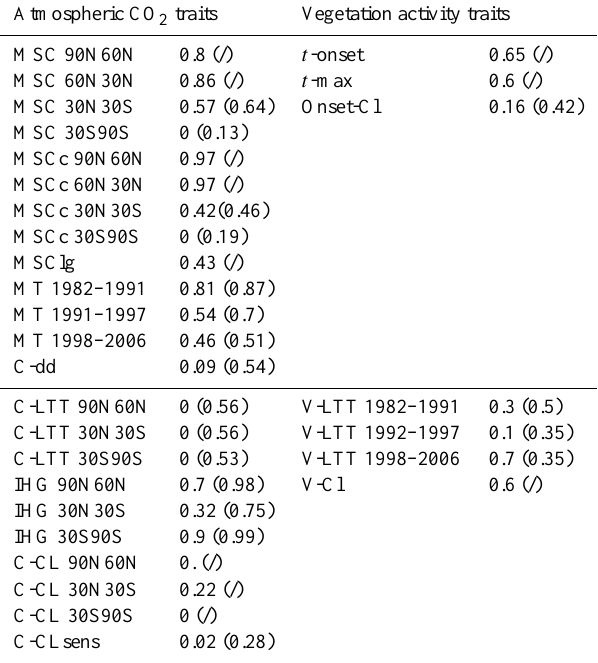
Table 4. Final scores of atmospheric CO 2 and vegetation activity. Atmospheric CO 2 scores are reported per latitudinal band. The nu- merical values prior of the scaling to the baseline benchmark are reported in brackets where they differ from the final scores. For the acronyms refer to Tables 2 and